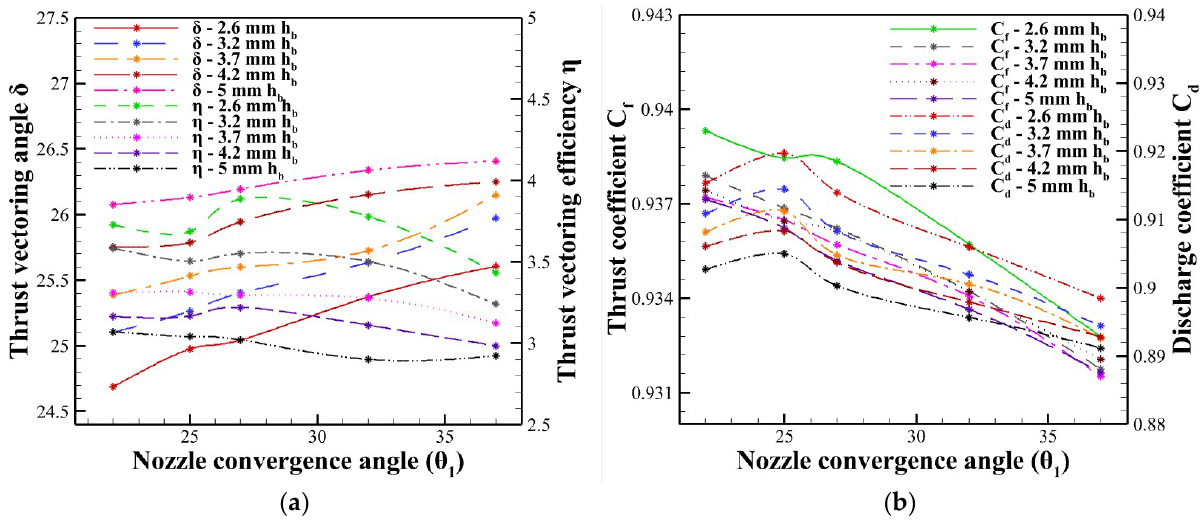
Figure 14. ( a ) refers to the trend of vectoring angle and vectoring efficiency. ( b ) refers to the trend of thrust and discharge coefficient with nozzle convergence angle.